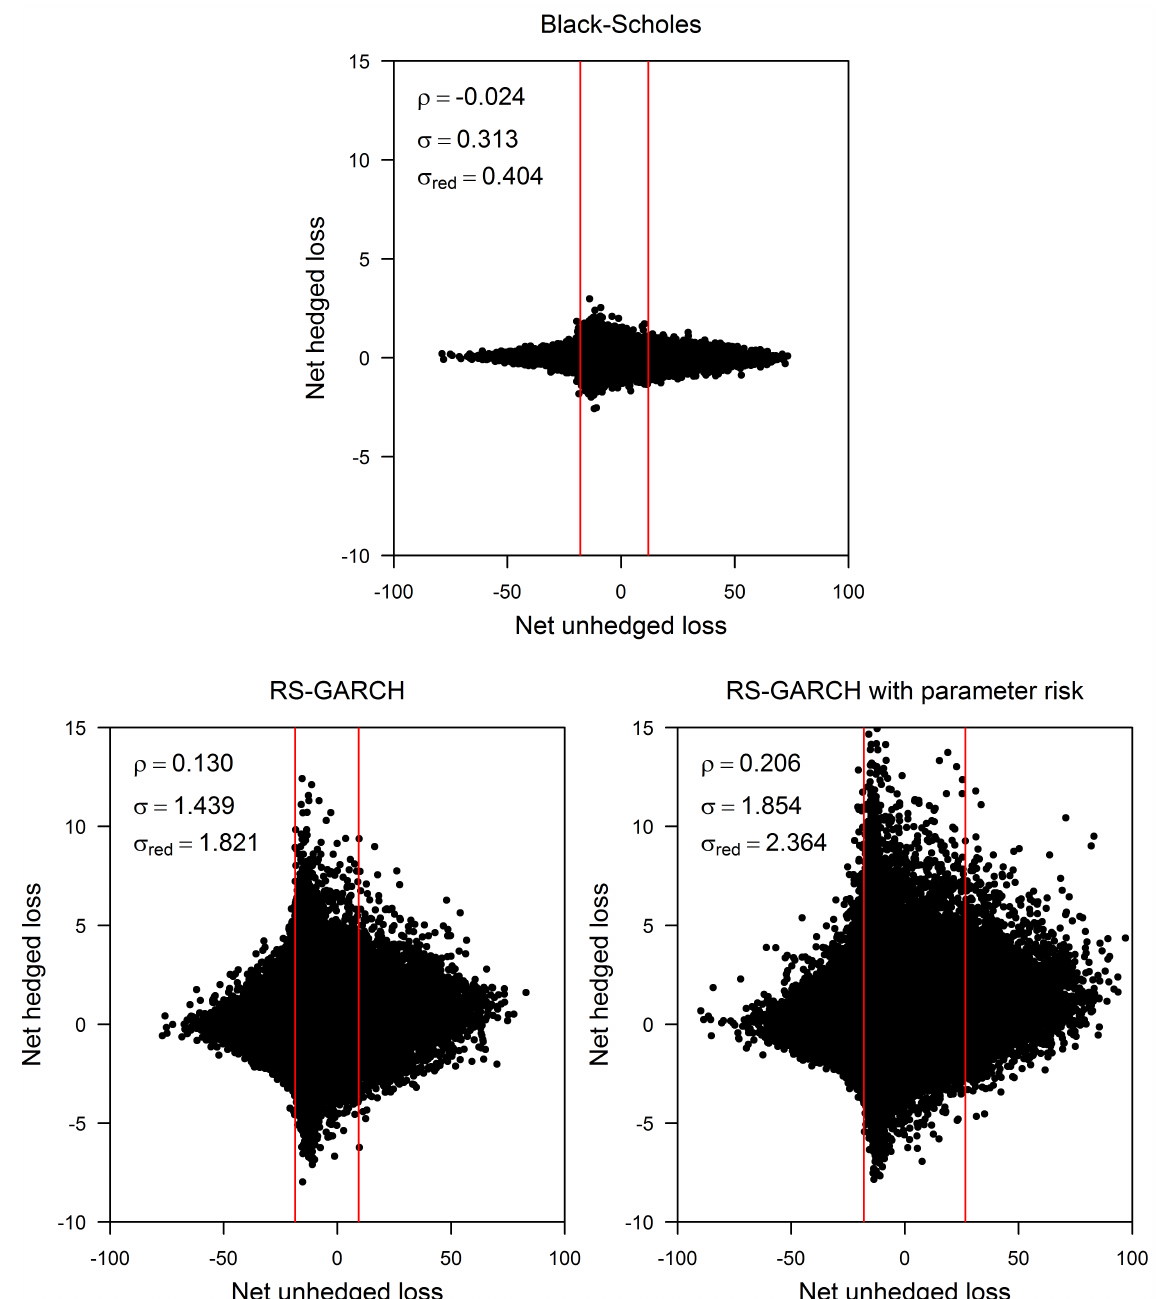
Figure 3 – Relationship between the net hedged loss and the net unhedged loss based on 100,000 daily scenarios projected with the Black-Scholes model (top panel), the RS-GARCH model (bottom-left panel) and the RS-GARCH model with parameter risk (bottom-right panel).